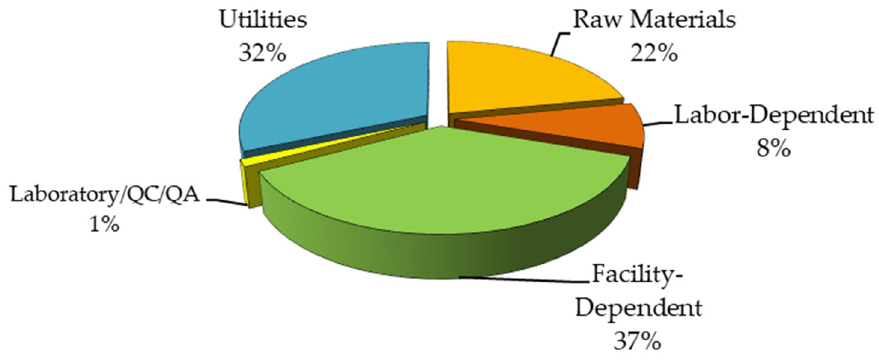
Figure 6. Annual operating cost breakdown. Table 6. A detailed list of materials and utilities cost .